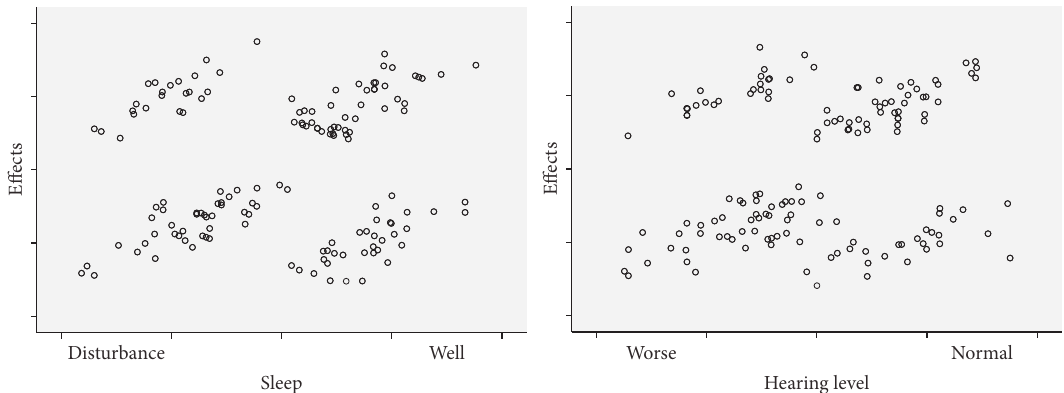
Figure 1: Correlations were observed between sleep and hearing level and efficacy of rTMS. The intervention was more likely to suppress tinnitus in subjects with normal hearing and those without sleep disturbance.